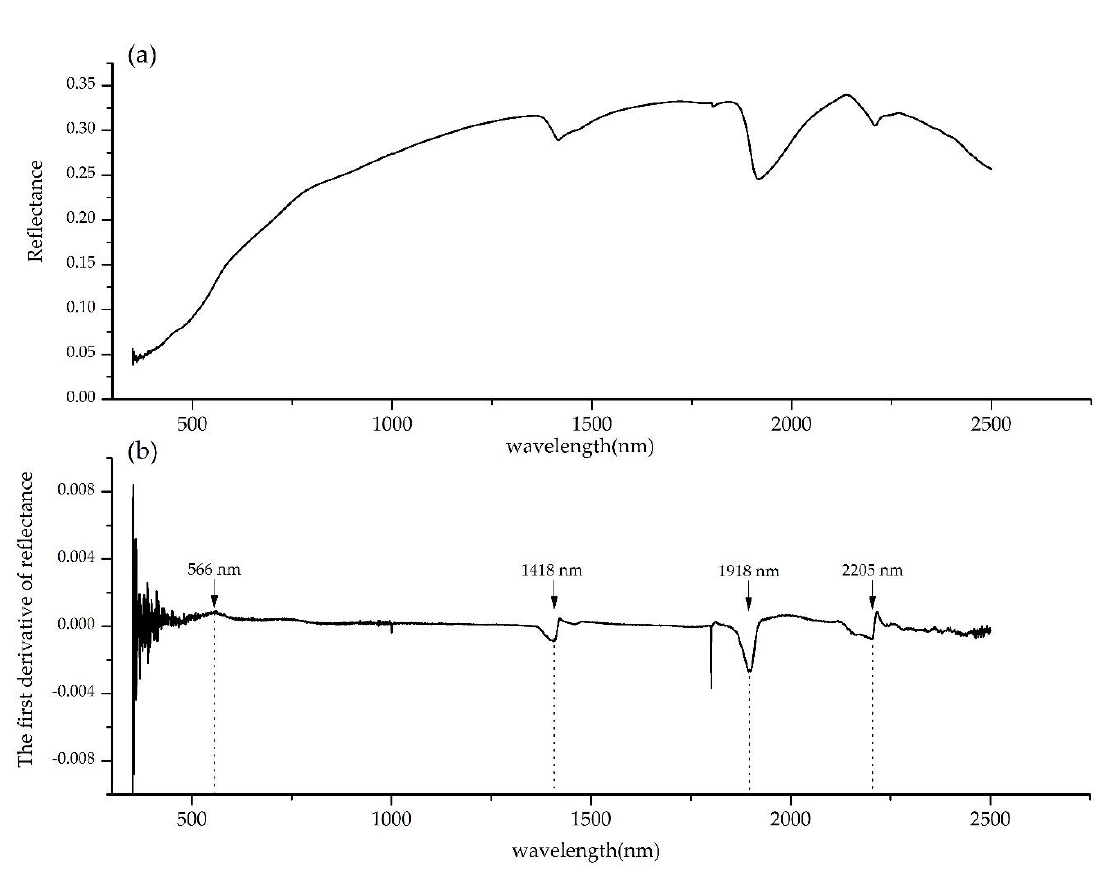
Remote Sens. 2018 , 10 , x FOR PEER REVIEW Figure 3. Average reflectance spectra ( a ) and its first derivative ( b ). Figure 3. Average reflectance spectra ( a ) and its first derivative ( b ).